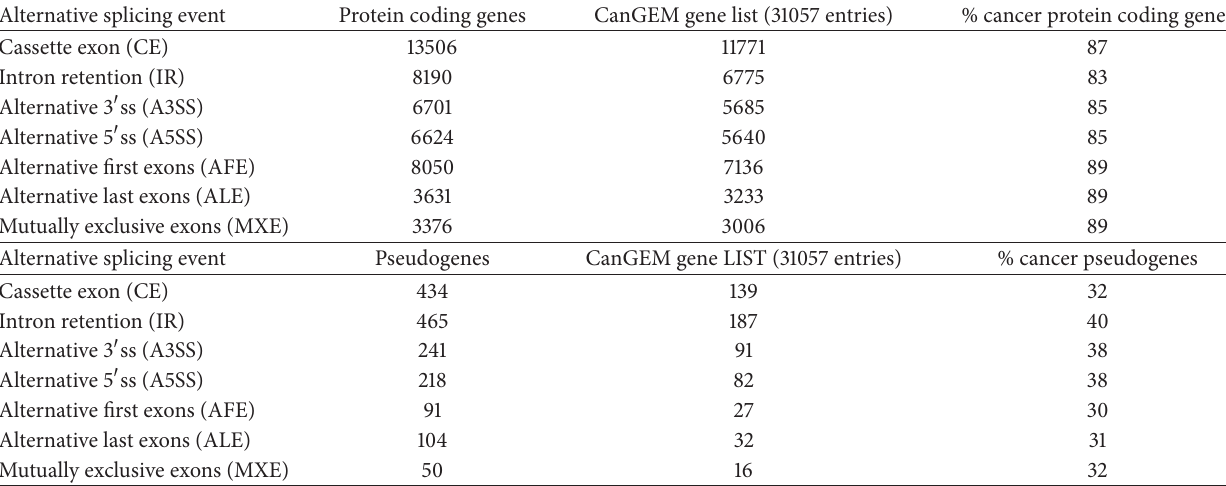
Table 1: Alternative splicing events detected in protein coding genes and pseudogenes implicated in cancer.